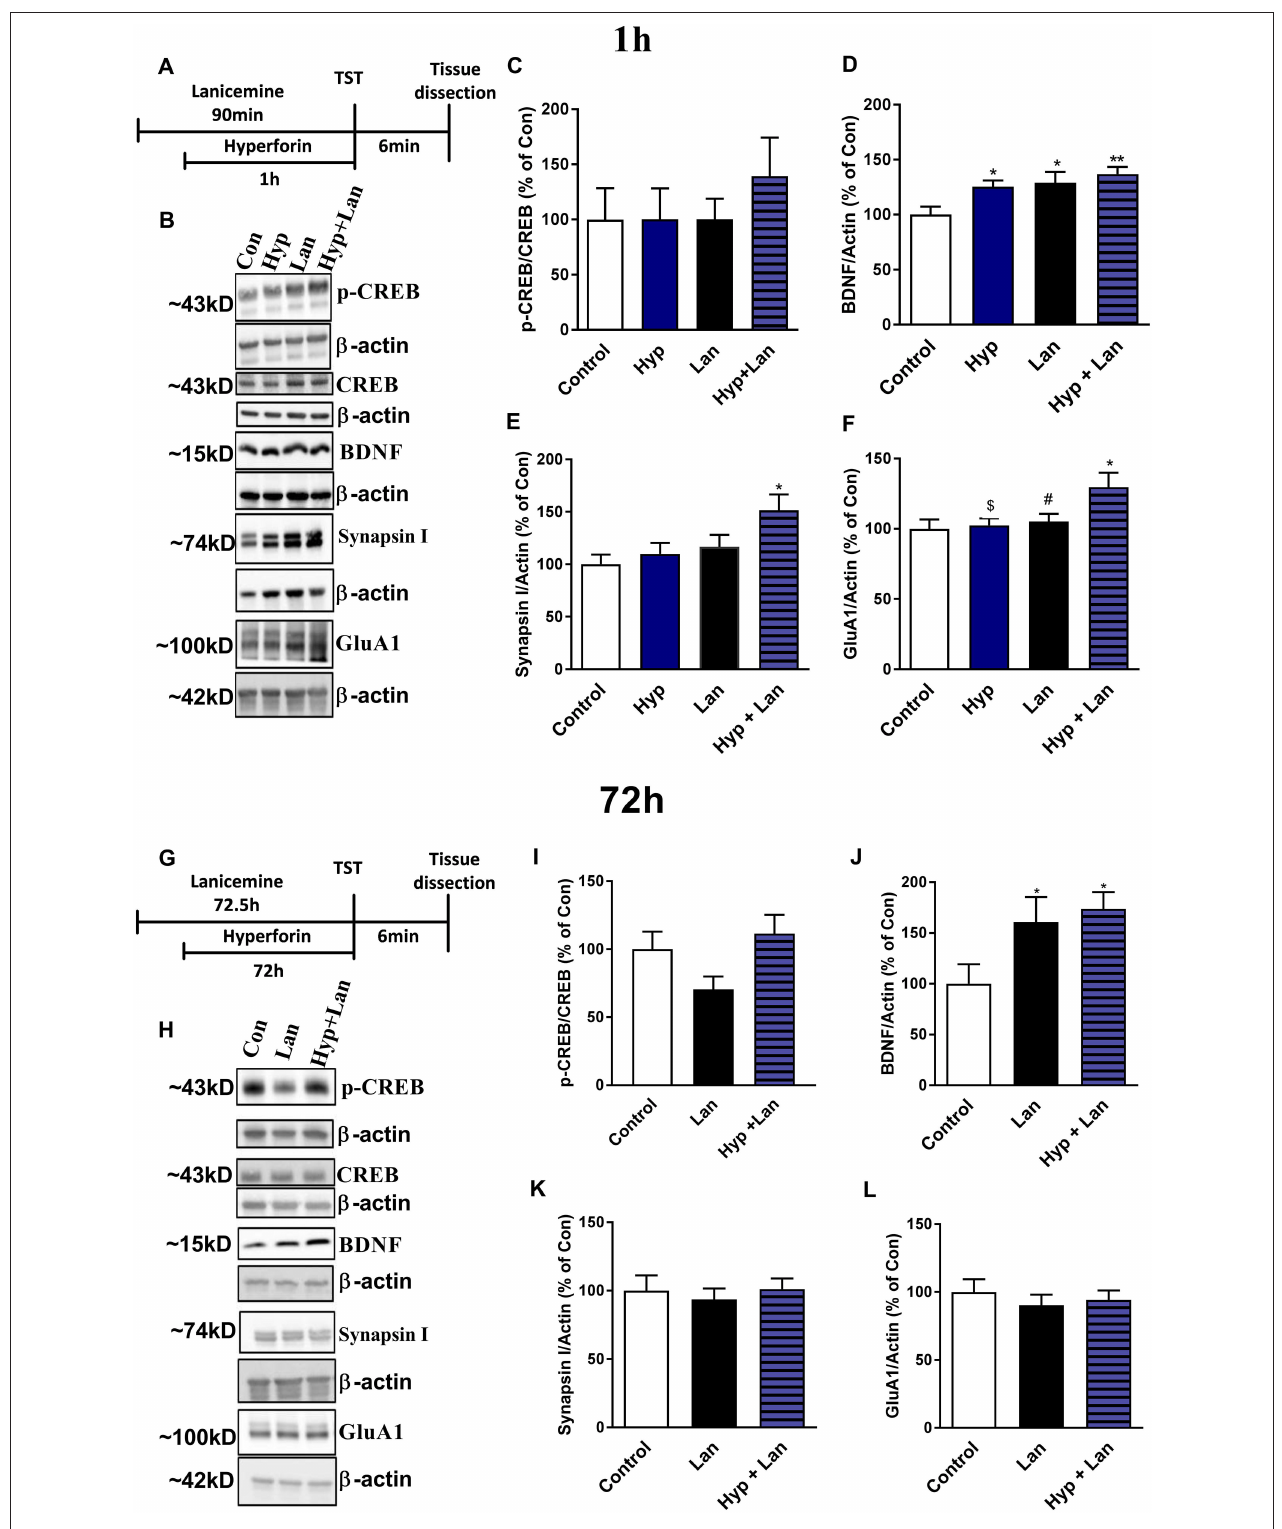
FIGURE 7 | The effect of the administration of single doses of hyperforin (Hyp), lanicemine (Lan) and hyperforin + lanicemine (Hyp + Lan) on the expression of p-CREB, total CREB, BDNF, Synapsin I, and GluA1 subunit of AMPA receptors. (A) Experimental schedule of drug treatments. (B) Representative blots.